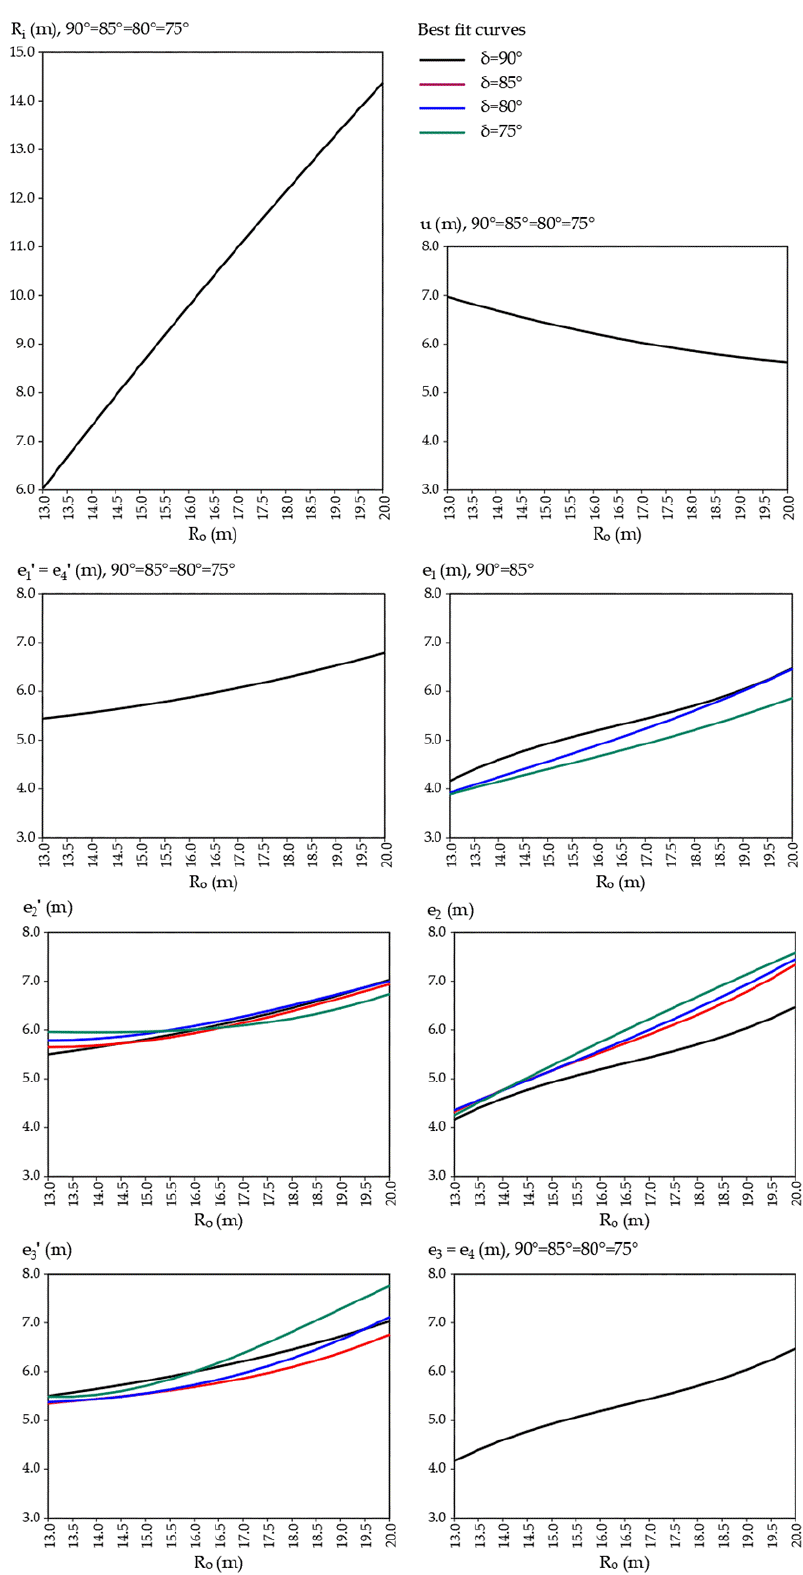
(cid:48) , and u as a function of R i , e j , e j